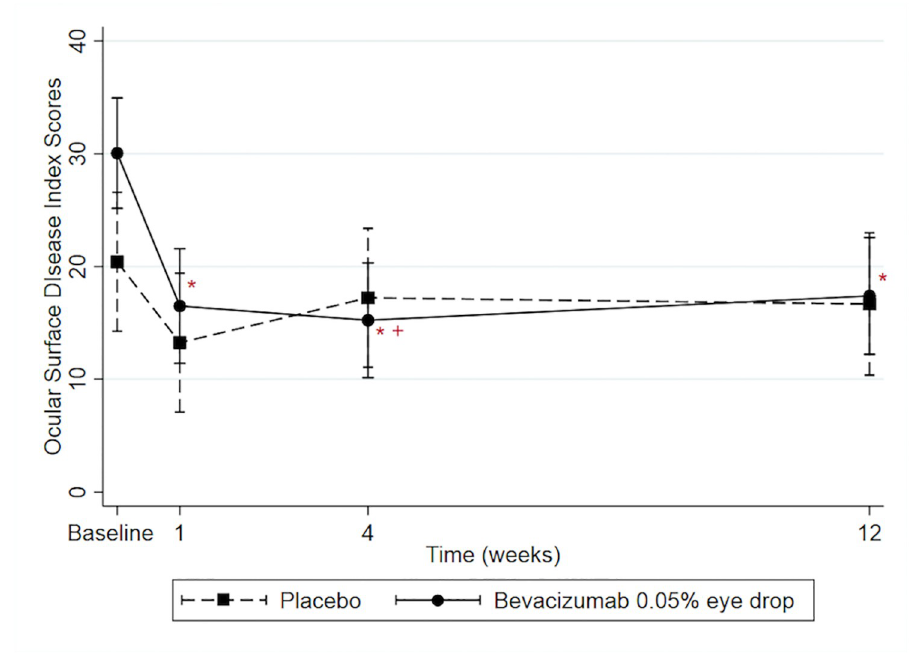
Fig 4. Predicted Ocular Surface Disease Index (OSDI) score (0–100) with 95% confidence intervals. � Represents significance difference compared with baseline within group (P < 0.05). + Represents significance difference in the difference of OSDI scores between the bevacizumab 0.05% eye drops group and the placebo group compared with the difference between the two groups at baseline (P < 0.05).